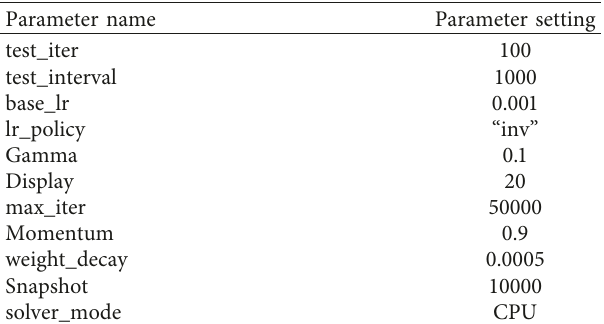
Table 6: Convolutional neural network parameter